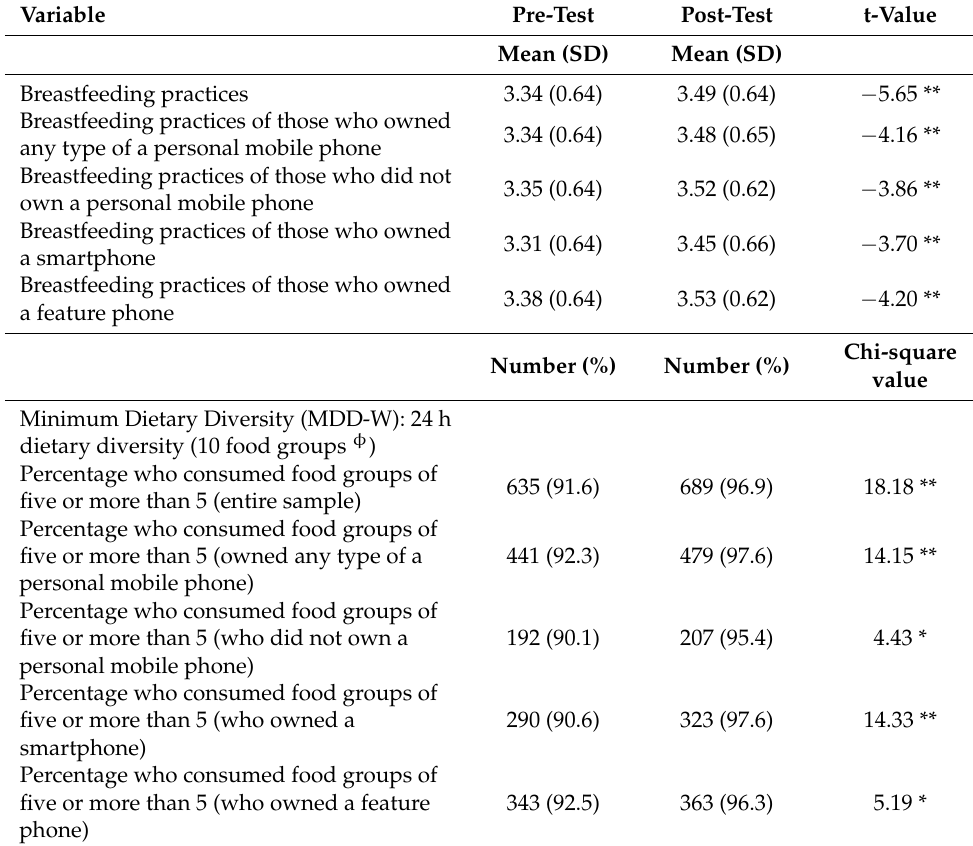
Table 6. Practices of the entire sample (unless